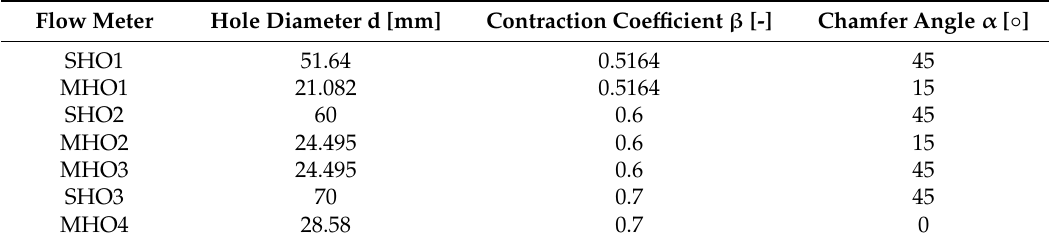
Table 2. Examined geometries of flow